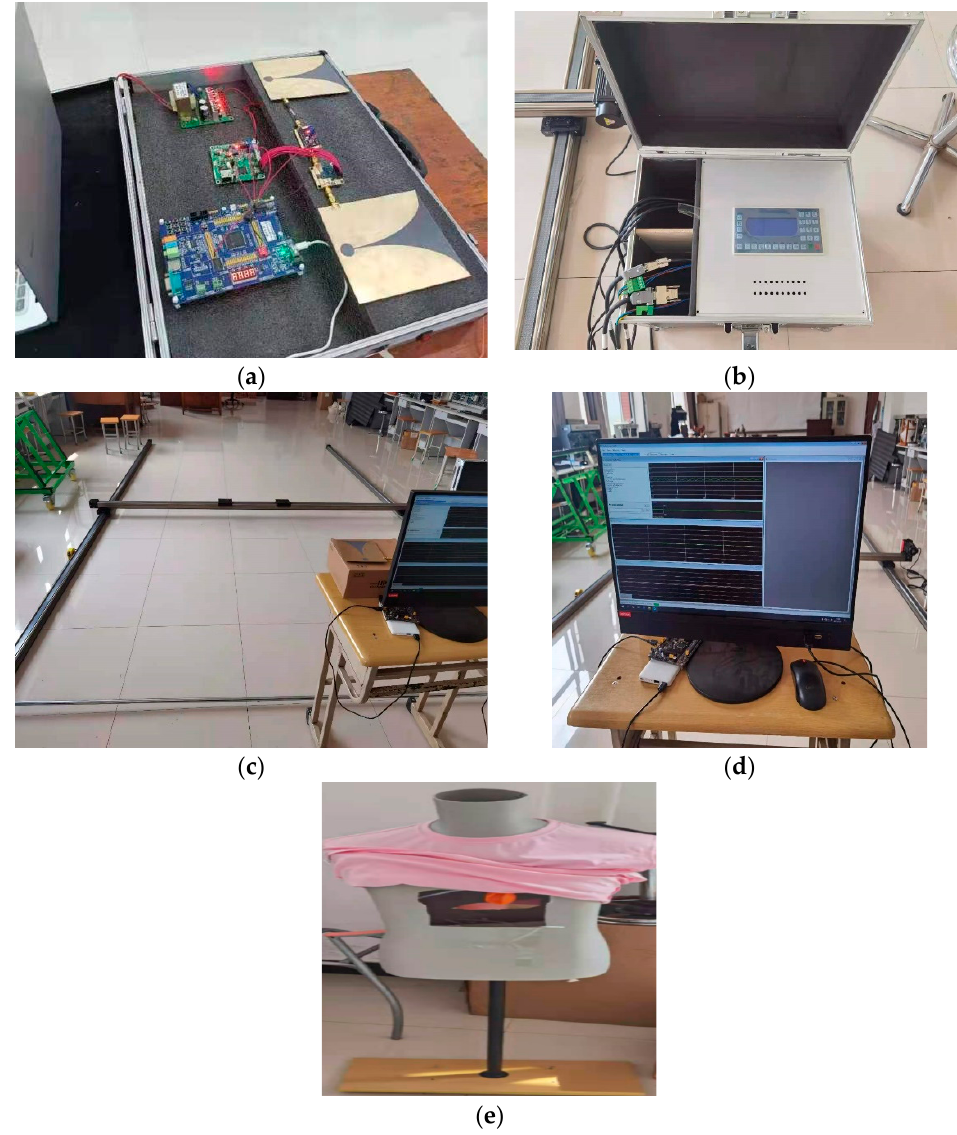
Figure 12. Experiment platform. ( a ) Radar transceiver equipment. ( b ) Experimental platform control cabinet. ( c ) Position mobile module. ( d ) Host computer. ( e ) Breathing and Heartbeat Simulator. During the experiment, the UWB radar system was placed on a table 0.85 m from the ground. The model was facing the radar system, and the respiratory frequency of the human simulated lungs was set to 0.3 Hz by controlling the single-chip microcomputer.